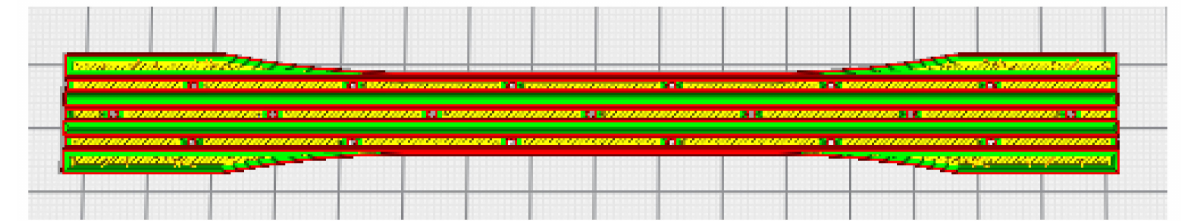
Figure 3. Layer view of solid CF rod reinforced with polylactic acid(PLA) specimen.